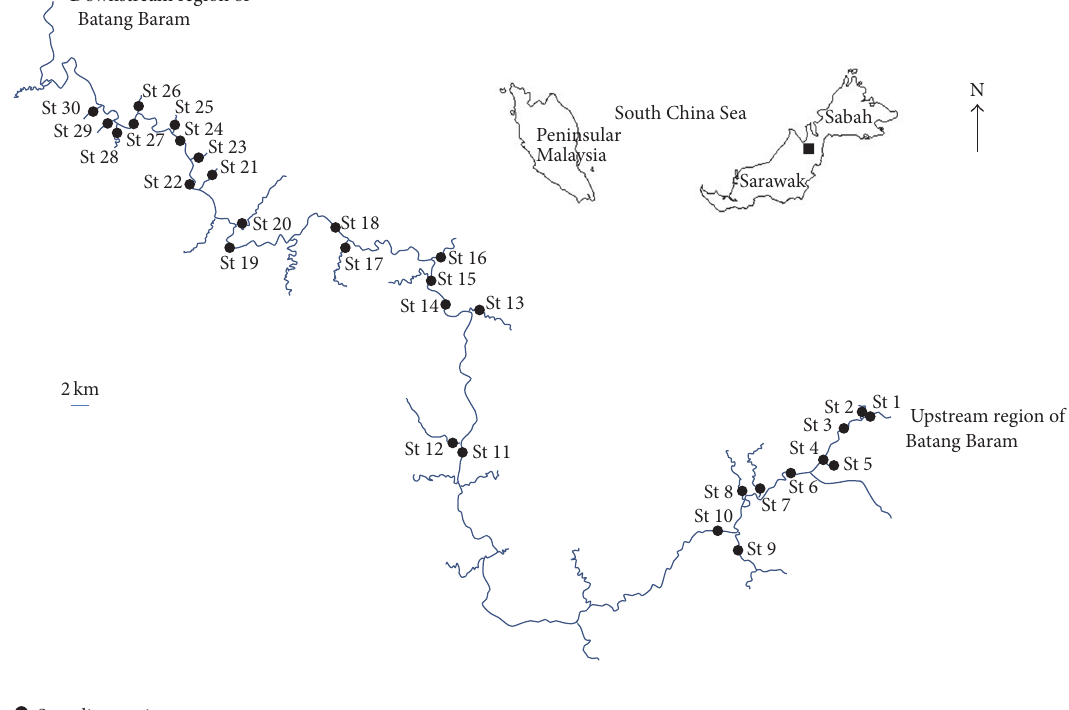
Figure 1: The study area in Sarawak state and location of the 30 sampling stations along the Batang Baram and its tributaries in the present